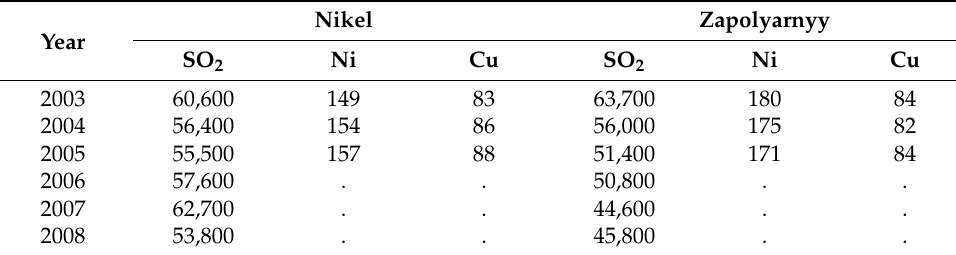
(km) and direction (to the northeast, east, south, or southwest) from the nearest polluter; grey colour indicates lakes. Coordinates of the study sites are provided in Table 2. Insert: The position of the study area in Northern Europe. Table 1. Atmospheric emissions of principal pollutants from the copper–nickel smelter at Nikel and from the ore-roasting plant in Zapolyarnyy (metric tons) from 2003 to 2008 (after [11,23–25]). Data on nickel and copper emissions for 2006–2008 are not available.